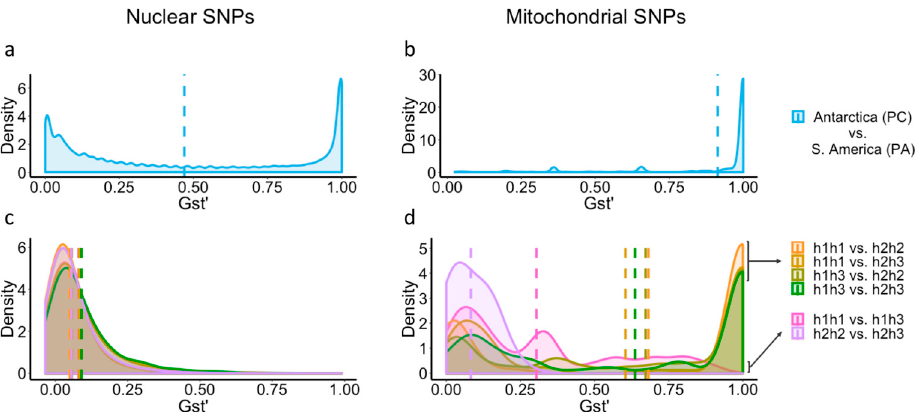
Figure 4. Density distributions of GST’ values estimated by pairwise comparison between South American and Antarctic populations of A. eightsii based on nuclear and mitochondrial SNPs ( a , b ) and between Antarctic mitotypes based on nuclear and mitochondrial SNPs ( c , d ). Dashed lines represent the mean GST’ of the correspondingly colored distribution. Note that to ease visualization, comparisons between continents do not involve comparisons within Antarctic mitotypes, and comparisons between mitotypes do not include the mitotype from South America (h4h4). A combined graphic representation would illustrate a bimodal distribution for both data sets (mitochondrial and nuclear SNPs), with most of the values close to zero for every comparison within Antarctic mitotypes and a high proportion of values close to one for every comparison between Antarctic and South American groups.